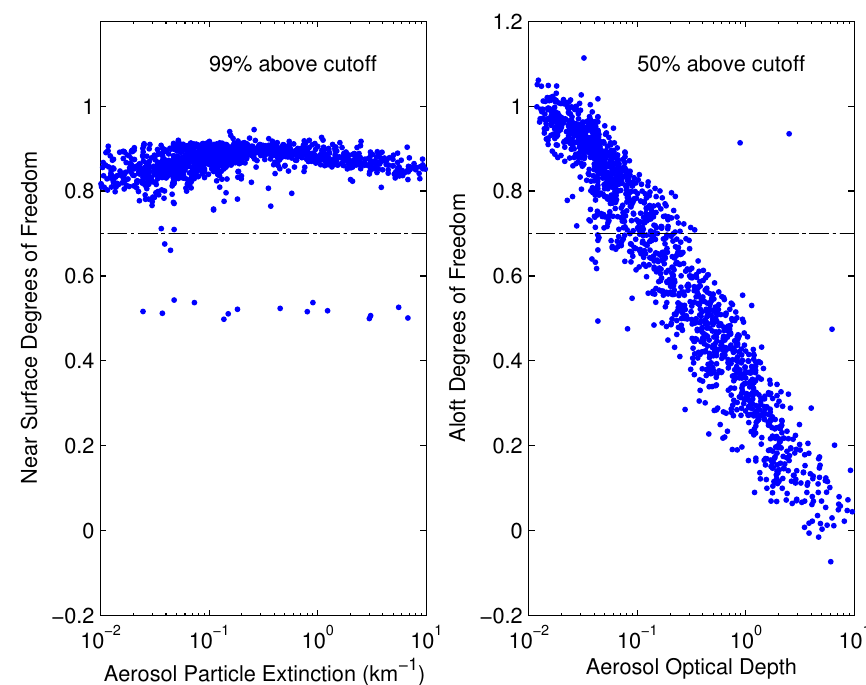
Figure 3. The left panel shows the degrees of freedom associated with the VCD 200m as a function of near-surface aerosol particle extinction. The right panel shows the degrees of freedom associated with the VCD Residual as a function of the aerosol optical depth. The dashed line illustrates the cutoff we have chosen for sufficient information